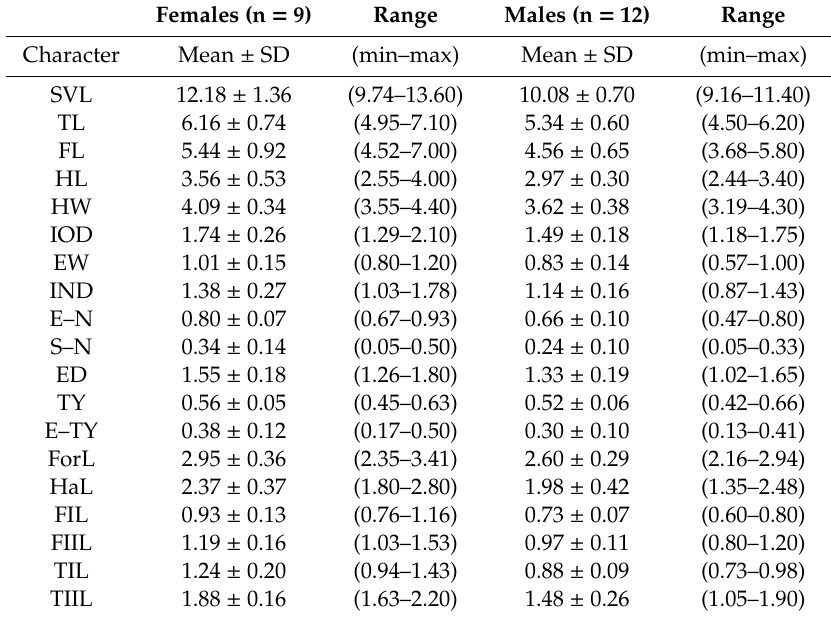
Table1. Measurements(inmm)ofmalesandfemalesofthetypeseriesof Noblellalosamigos sp. n. Seesection on morphological characters for definition of each character. Abbreviations: SD = standard deviation, SVL = snout-vent length, TL = tibia length, FL = foot length, HL = head length, HW = head width, ED = eye diameter, TY = tympanum diameter, IOD = interorbital distance, EW = upper eyelid width, IND = internarial distance, E–N = and eye–nostril distance, E-TY = eye to tympanum distance, ForL = forearm length, HaL = hand length, FIL = finger I length, FIIL = finger II length, TIL = toe I length, TIIL = toe II length. Ranges are included in